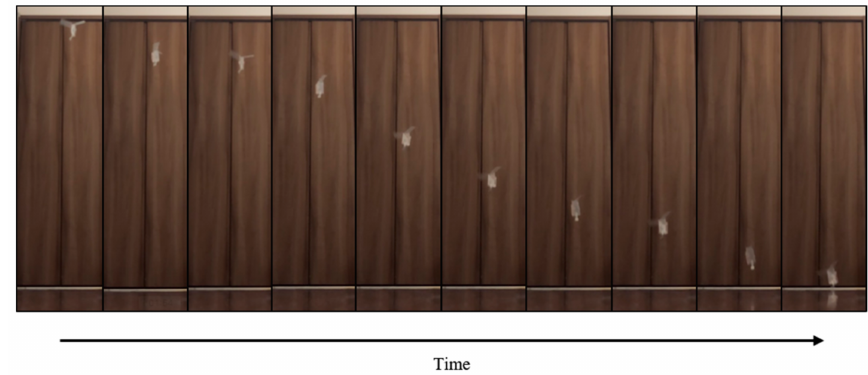
Figure 19. Drop experiment of the sheet type robot.